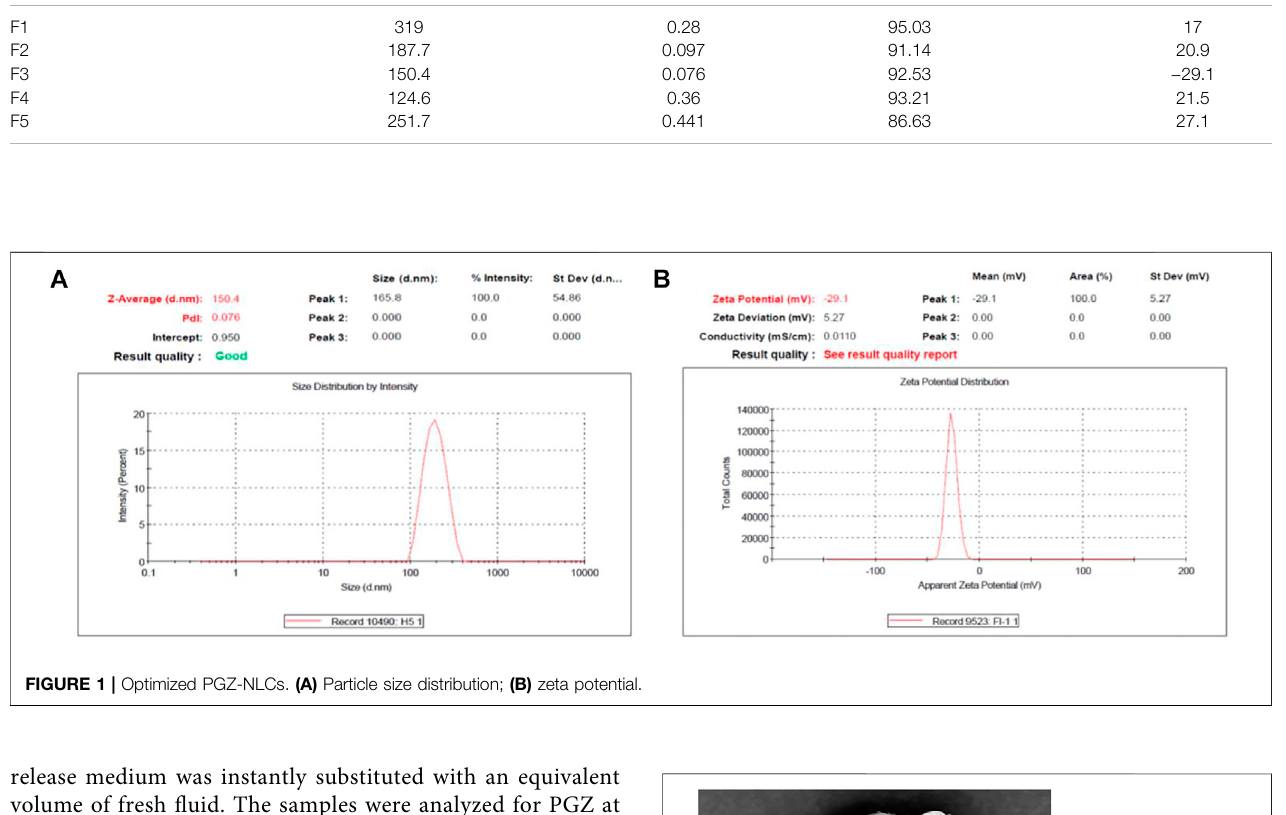
TABLE 2 | Experimental results of various PGZ-NLC formulations. Formulation code